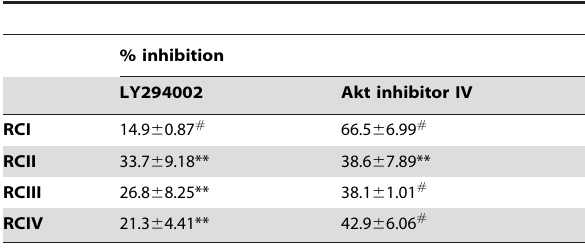
Table 1. Inhibition of enzyme activities of respiratory